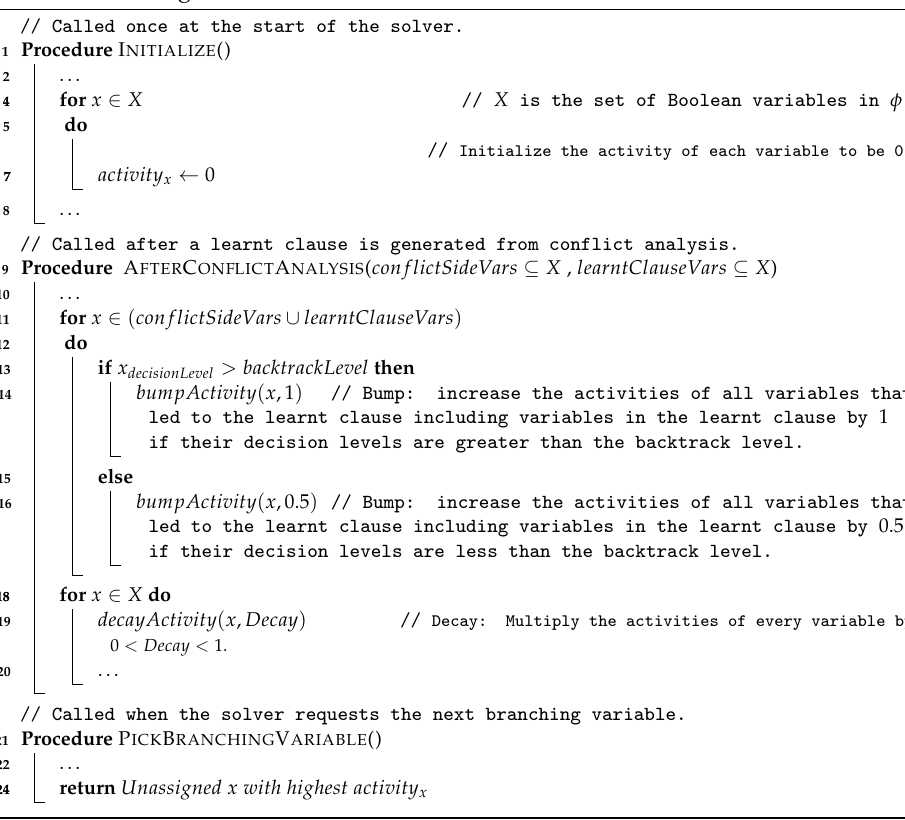
Algorithm A2: VSIDS decision heuristic. All procedures are part of the CDCL framework in Algorithm